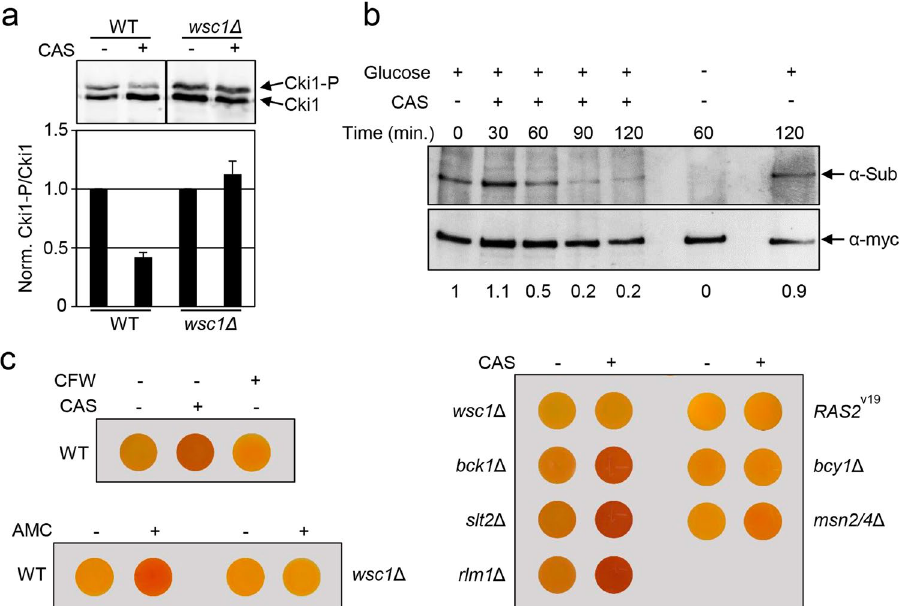
Figure 4. Caspofungin controls PKA activity in a Wsc1-dependent manner. ( a ) Wild-type (WT) and wsc1 Δ cells harboring pRS423-pr CUP -6xMYC- cki1 2_200 ( S125/130A ) plasmid were grown in YPD medium in the absence and presence of CAS for 2 h. PKA-dependent phosphorylation of Cki1 was analyzed by whole cell extraction and Western blot analysis using an anti c-myc antibody. A representative Western blot is shown (upper panel). Ratios of phosphorylated (Cki1-P) and non-phosphorylated (Cki1) forms of Cki1 in the presence of CAS relative to untreated cells are shown for each strain in the lower panel. The means and SD of three (n = 3) independent experiments are indicated. ( b ) The PKA-dependent phosphorylation of Pat1 was lost upon CAS treatment. Wild-type cells expressing a myc-tagged Pat1 were grown to mid-log phase in YPD medium and then treated or not with CAS (15 ng/ml) or transferred to a medium lacking glucose (YP) for the indicated time. The level of PKA phosphorylation ( α -Sub) was assessed by Western blotting with the anti-PKA substrate antibody. Numbers indicate the relative amounts (quantified by densitometric analysis) of Phospho-Pat1 with respect to time zero normalized with respect to total Pat1 ( α -myc). ( c ) Glycogen accumulation is induced in the presence of CAS. Cells of the indicated yeast strains ( RAS2 val19 corresponds to the wild-type strain expressing this RAS2 allele) were grown on YPD medium in the absence or presence of CAS (15 ng/ml), Calcofluor white (CFW, 5 µ g/ml), or aminocandin (AMC, 15 ng/ml) for 2 h. Cells were then collected and resuspended in a solution of 0.2% iodine/0.4% potassium iodide and, after 3 min., were spotted onto YPD plates and photographs were taken. The darker the color, the higher the amount of glycogen that was accumulated. Glycogen provides an indirect measurement of cAMP/PKA